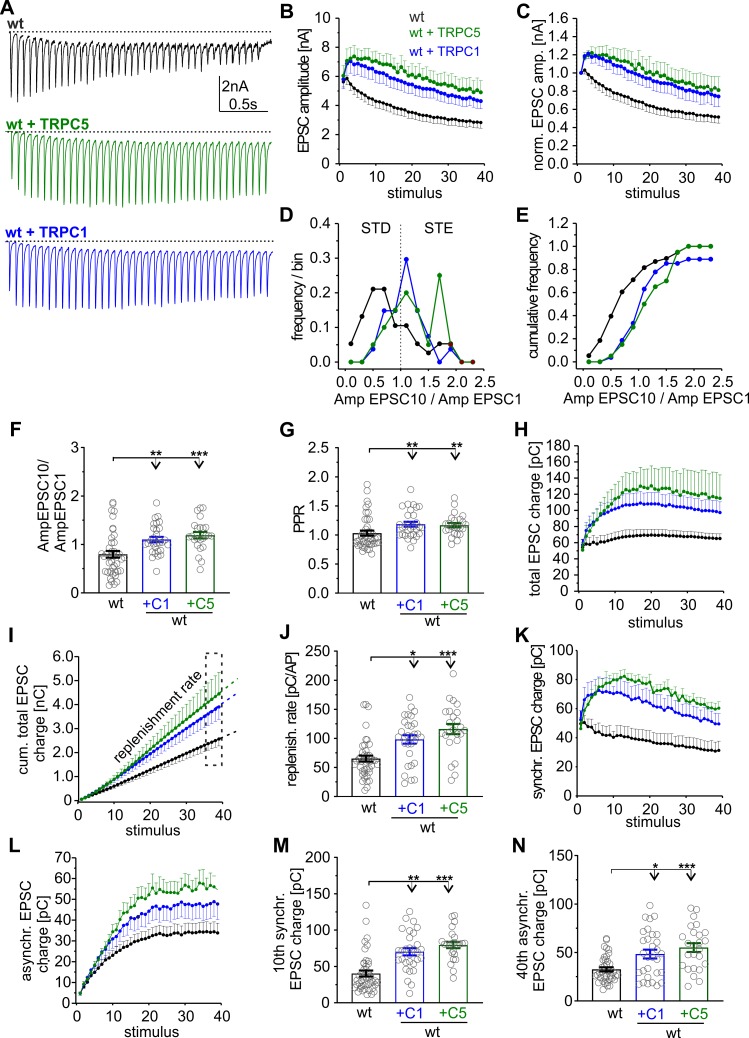
Expression of either TRPC1 or TRPC5 in wt neurons turns synaptic depression into STE.(A) Sample recordings of EPSCs triggered by HFS (20 Hz, 40 AP/2 s) of autaptic wt neurons and those expressing TRPC5 or TRPC1. (B) Activity-dependent increase in the EPSC amplitudes in wt cells expressing C1 or C5. (C) TRPC expression causes STE of synaptic signaling (data were normalized to the initial peak EPSC amplitude). (D and E) Expression of TRPC1 or TRPC5 shifts the frequency distribution of the AmpEPSC10/AmpEPSC1 ratios to higher values. (F) Mean AmpEPSC10/AmpEPSC1 ratio for the indicated groups (+C1, p = 0.002; +C5, p = 0.0001; versus wt). (G) Mean paired pulse ratio (+C1, p = 0.0036; +C5, p = 0.00585; versus wt). (H) Time course of total charge transfer. (I) Mean cumulative total charge transfer during HFS. The replenishment rate was determined from the slope of the cumulative plot (last 4 data points). (J) The replenishment rate is significantly enhanced in cells expressing either C1 or C5 (+C1, p = 0.003; +C5, p = 0.00001; versus wt). (K and L) Time courses of synchronous (K) and asynchronous charge transfer (L) during the stimulus train. (M and N) The 10th EPSC charge (M) and the 40th asynchronous charge (N) are significantly increased with TRPC expression (10th charge: +C1, p = 0.00001; +C5, p = 0.0000001; versus wt; 40th asynchronous: +C1, p = 0.02; +C5, p = 0.0005; versus wt). Data were collected from the following number of cells: wt, n = 43; wt + TRPC1, n = 30; wt + TRPC5, n = 24; *p < 0.05; **p < 0.01; ***p < 0.001; one-way ANOVA on ranks followed by Dunn’s post hoc test. Underlying data can be found in S1 Data. Amp, amplitude; AP, action potential; EPSC, evoked postsynaptic current; HFS, high-frequency stimulation; PPR, paired-pulse ratio; STD, short-term depression; STE, short-term enhancement; TRPC, transient receptor potential canonical; wt, wild type.